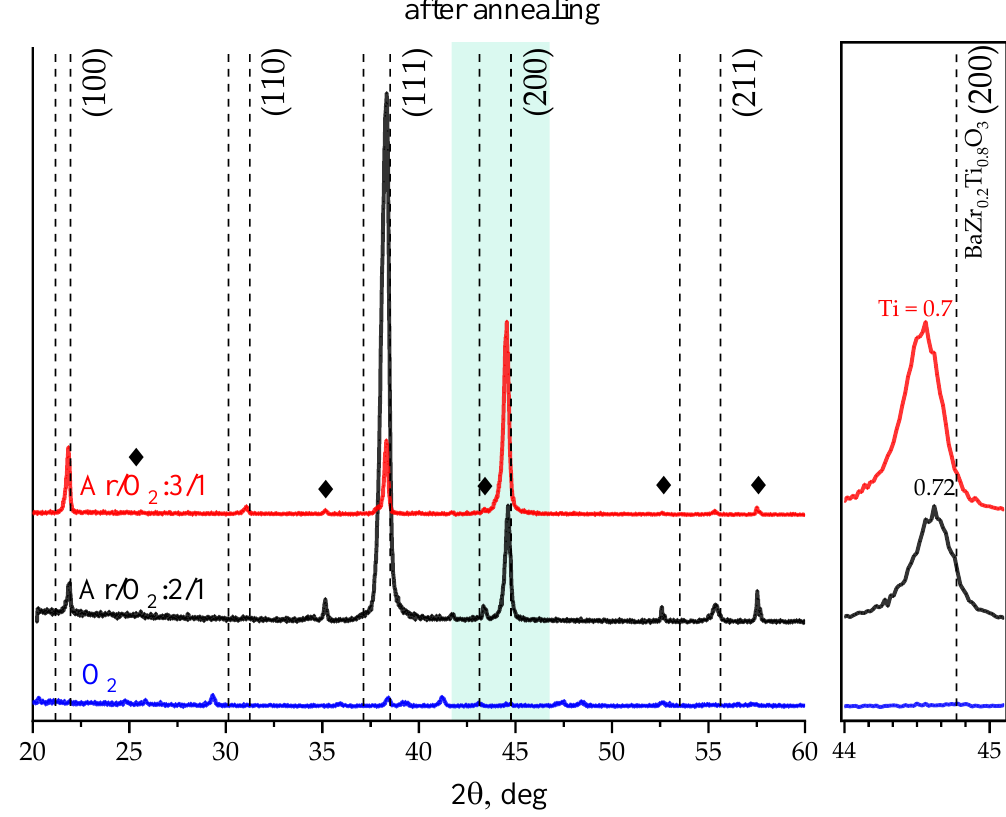
Figure 4. Diffractograms of BZT thin films on Al 2 O 3 substrates deposited at different oxygen concentrations in gas ambient at a substrate temperature of 800 °C after annealing at 1100 °C.